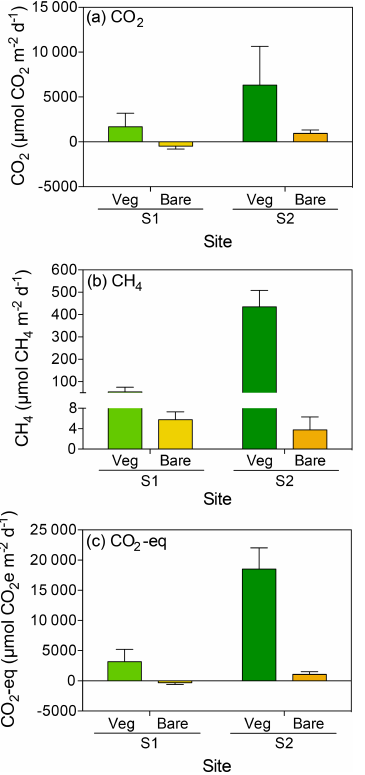
Figure 1. Mean + SE (a) CO 2 , (b) CH 4 and (c) CO 2 -eq fluxes in vegetated (green) and adjacent bare (yellow) sediments at two sites (S1 and S2) in the central Red